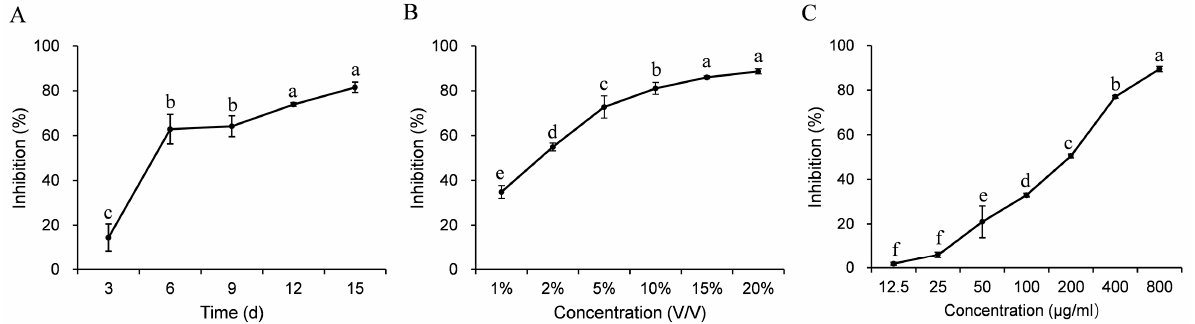
Figure 6. Antifungal activity of the cultures and the crude extract of Simplicillium lamellicola JC-1. The JC-1 strain of S. lamellicola was shake-incubated (20 ◦ C, 150 rpm) in potato dextrose broth (PDB) for 3 to 15 d, and the cultures were centrifuged at 9000 rpm to obtain the supernatant. ( A ) Time-course of the antifungal activity of the 3- to 15-day-old DB cultures; ( B ) dose effect of the antifungal activity of the 15-day old PDB cultures; ( C ) antifungal activity of the crude extract of JC-1 from the 15-day-old PDB cultures. In each graph, means ± S.E. labeled with the same letters are not significantly different ( p > 0.05) according to the least significant difference test.